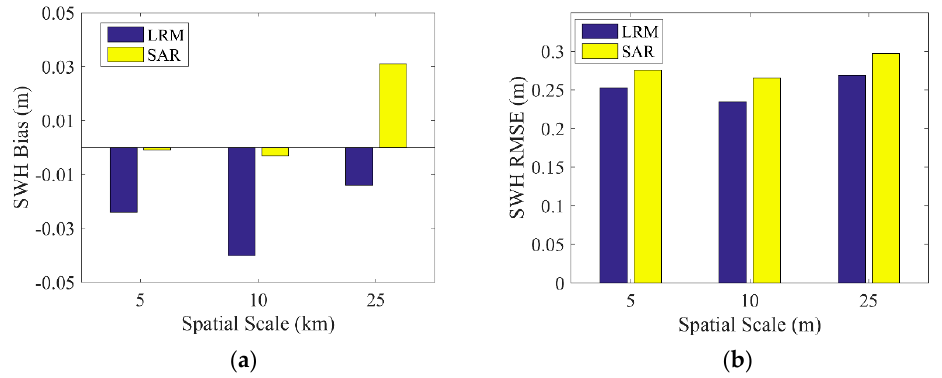
Figure 7. ( a ) Bias and ( b ) root-mean-square error (RMSE) of SWH difference between Sentinel-3A and buoy data at different spatial scales.